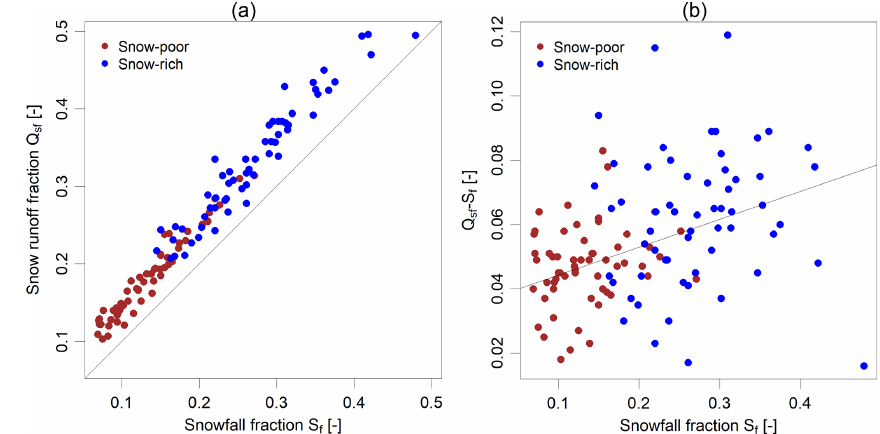
Figure 3. (a) A relation between snowfall fraction ( S f ) and snow runoff fraction ( Q sf ) for all study catchments. (b) A dependence of Q sf and S f difference on snowfall fraction. Individual points represent mean snowfall fractions and snow runoff fractions for snow-poor years (brown points) and snow-rich years (blue points) for individual catchments.